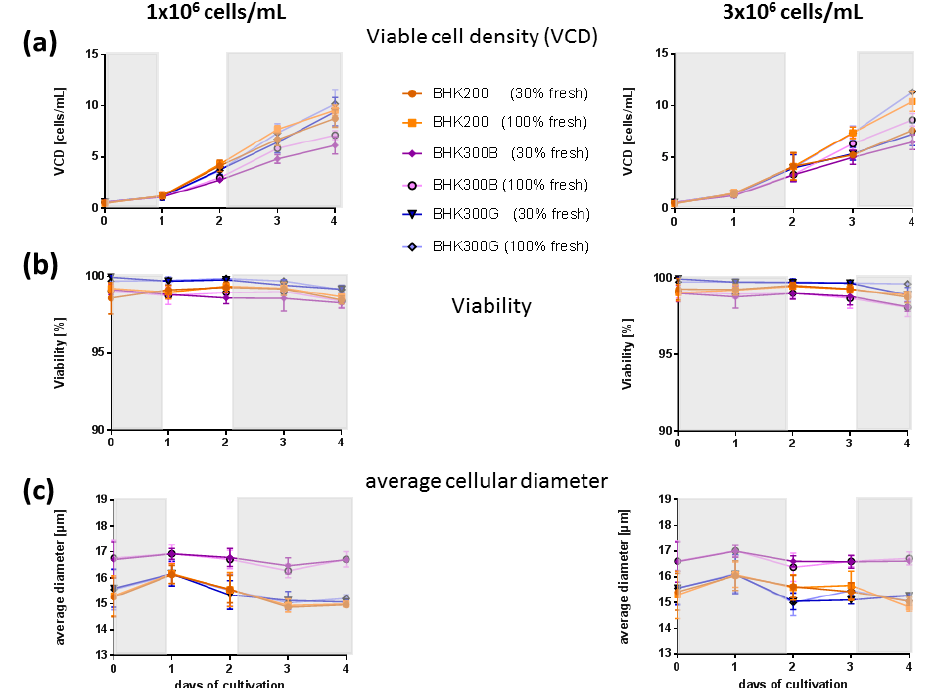
Figure 5. Cellular phenotype during batch cultivation. Cellular parameters such as ( a ) viable cell density (VCD) in cells / mL, ( b ) percent viability and ( c ) average diameter in µ m were evaluated for BHK200 (orange), BHK300B (violet) and BHK300G (blue). Highlighted in white is the period of time in which viral infection and cellular virus production would take place at cell densities of 1 × 10 6 cells / mL or 3 × 10 6 cells /